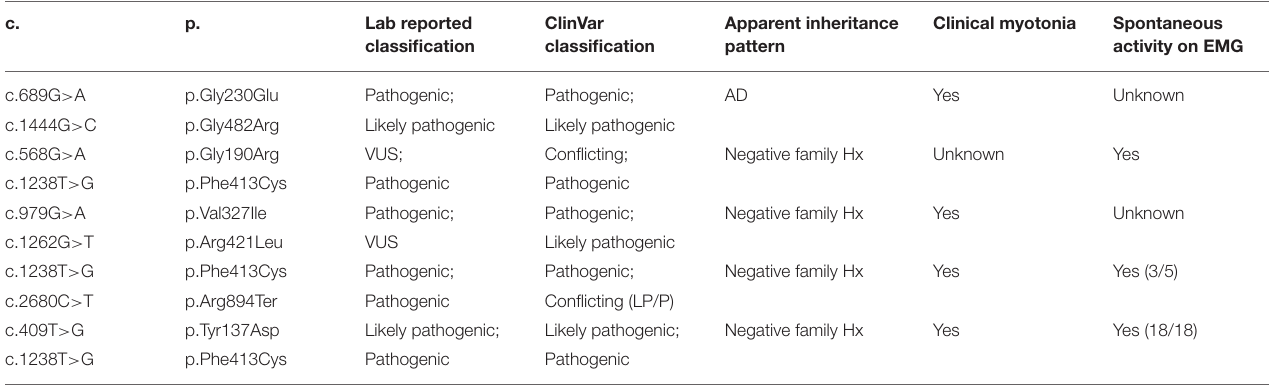
TABLE 3 | List of patients with two variants identified in CLCN1 .